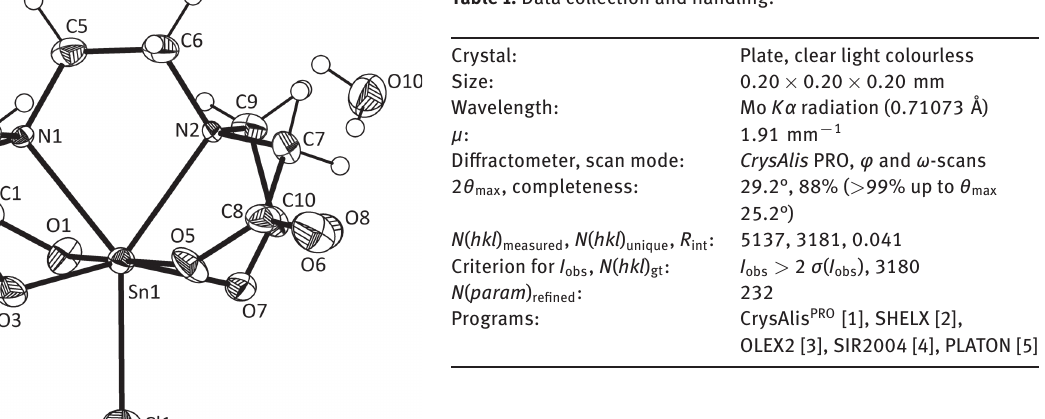
Table 1: Data collection and